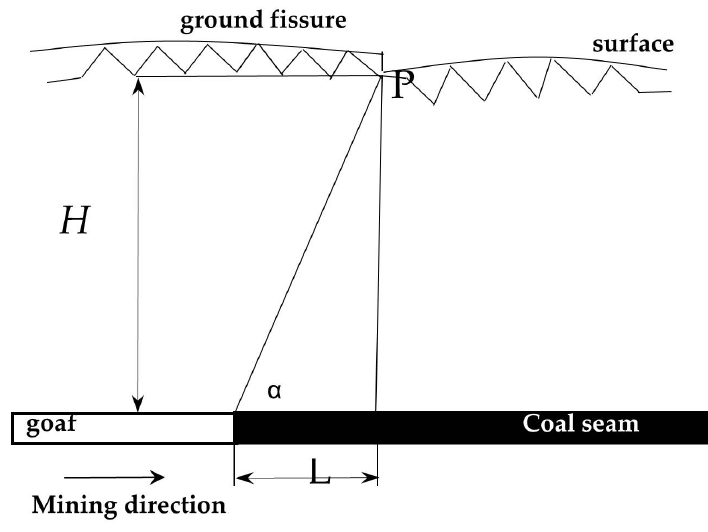
Figure 8. Panel outline of the ground fissure.